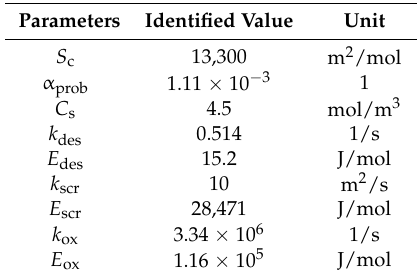
Table 1. Result of parameter identification.